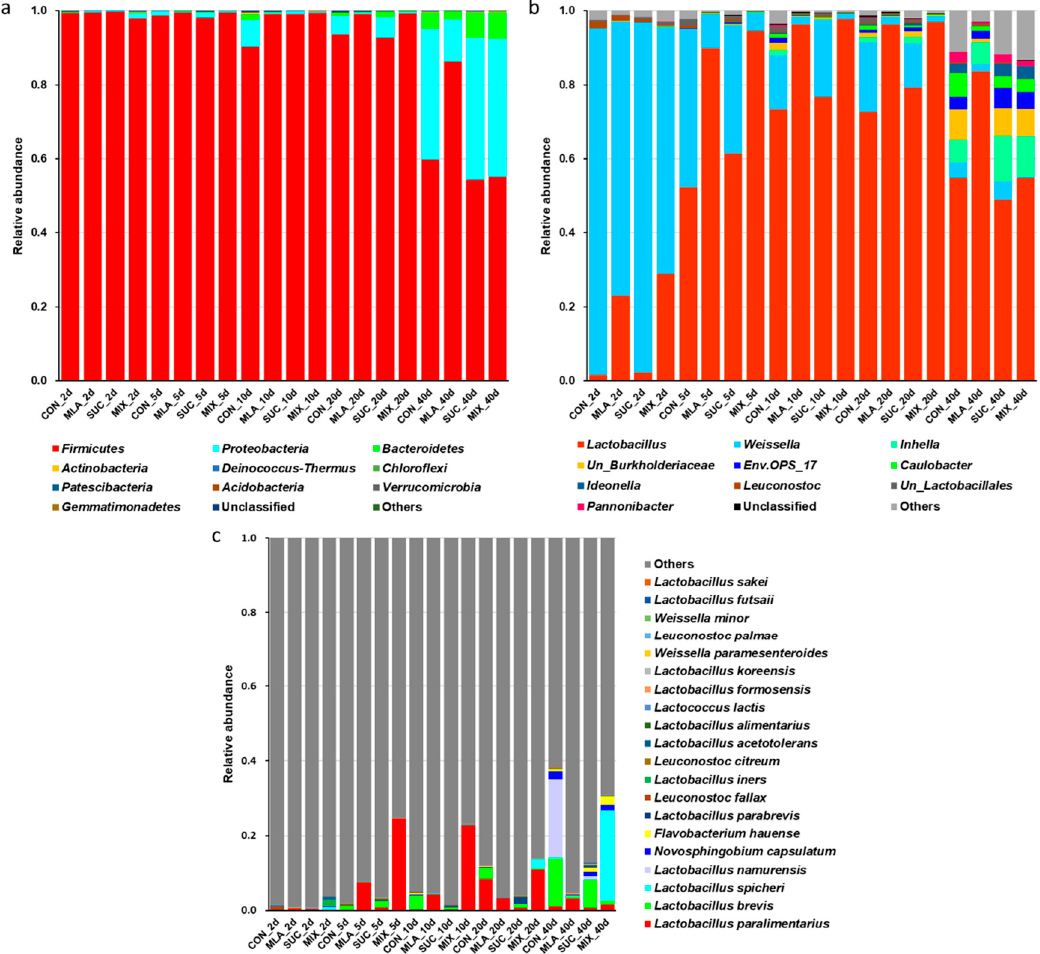
Figure 2. Effect of malic acid and sucrose on the bacterial communities at the phyla level ( a ), genera level ( b ), and species level ( c ) in Moringa oleifera leaves silage. CON, control group; MLA, 1% malic acid addition on the fresh weight (FW) basis; SUC, 1% sucrose addition on the FW basis; MIX, 1% malic acid and 1% sucrose addition on the FW basis.